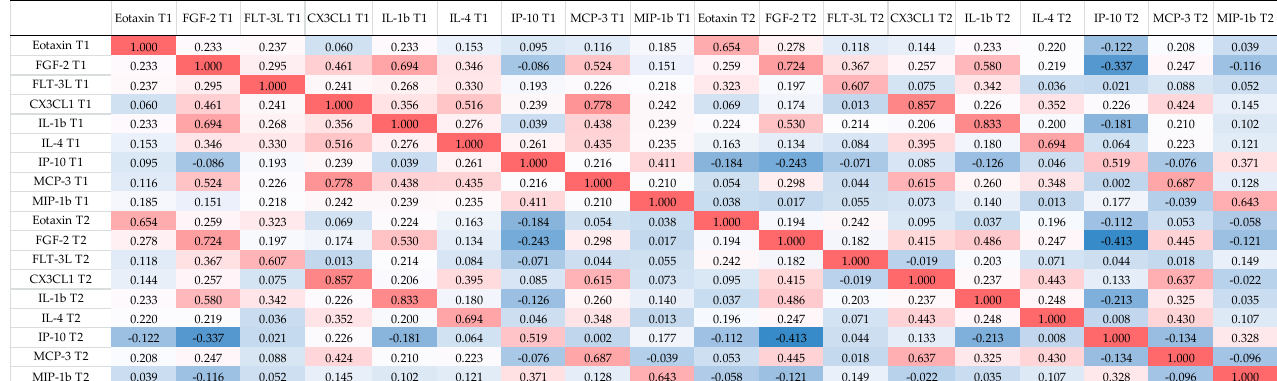
Figure 2. Correlation between different serum biomarkers in patients with aSAH. (Note: red indicates that the two parameters were positively correlated, and blue indicates that the two parameters were negatively correlated; the darker the color, the stronger the correlation). T1, serum sample at Day 1 after aSAH; T2, serum sample at Day 5–7 after aSAH. FGF-2, fibroblast growth factor-2; FLT-3L, Fms-related tyrosine kinase 3 ligand; CX3CL1, chemokine ligand 1, also known as fractalkine; IL-1b, interleukin-1b; IL-4, interleukin-4; IP-10, interferon gamma-induced protein 10, also known as C-X-C motif chemokine ligand 10 (CXCL10); MCP-3, Monocyte chemotactic protein-3; MIP-1b, macrophage inflammatory protein 1-beta; aSAH, aneurysmal subarachnoid hemorrhage; Statistical method: